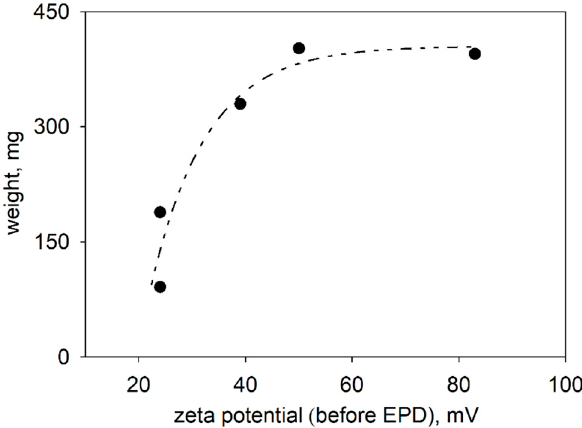
Figure 3. Dependence of weight of the deposited green body on the zeta potential of nanoparticles in the suspension.